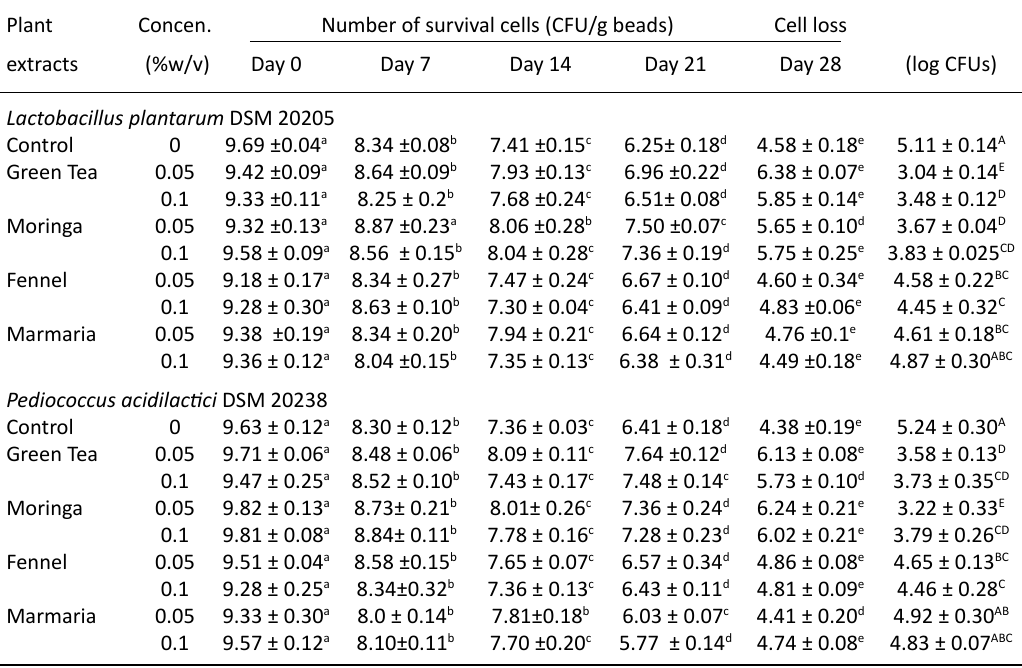
Table 2. Stability of two probiotic strains encapsulated with and without plant extracts during refrigerated storage Plant Concen. Number of survival cells (CFU/g